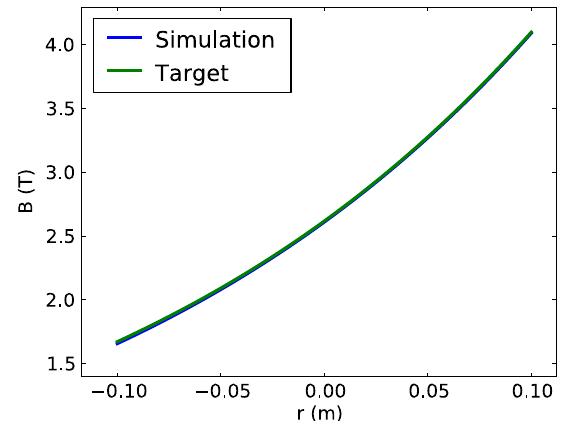
FIG. 44. Horizontal magnetic field in the septum as a function of the horizontal position. The real magnetic field is averaged over various vertical positions within the septum